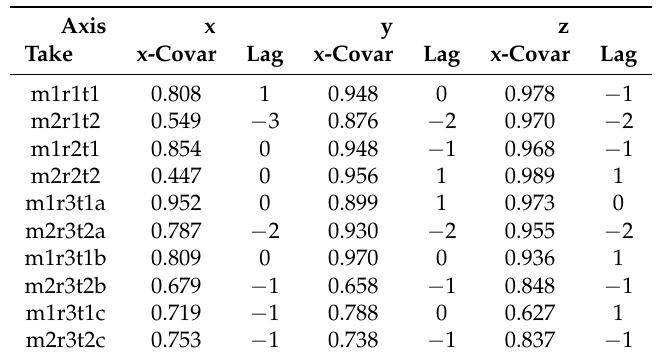
Table 3. Covariances (per axis) between linear accelerations from IMU and double derivatives of mocap positional data—selected takes from musicians 1 and 2.